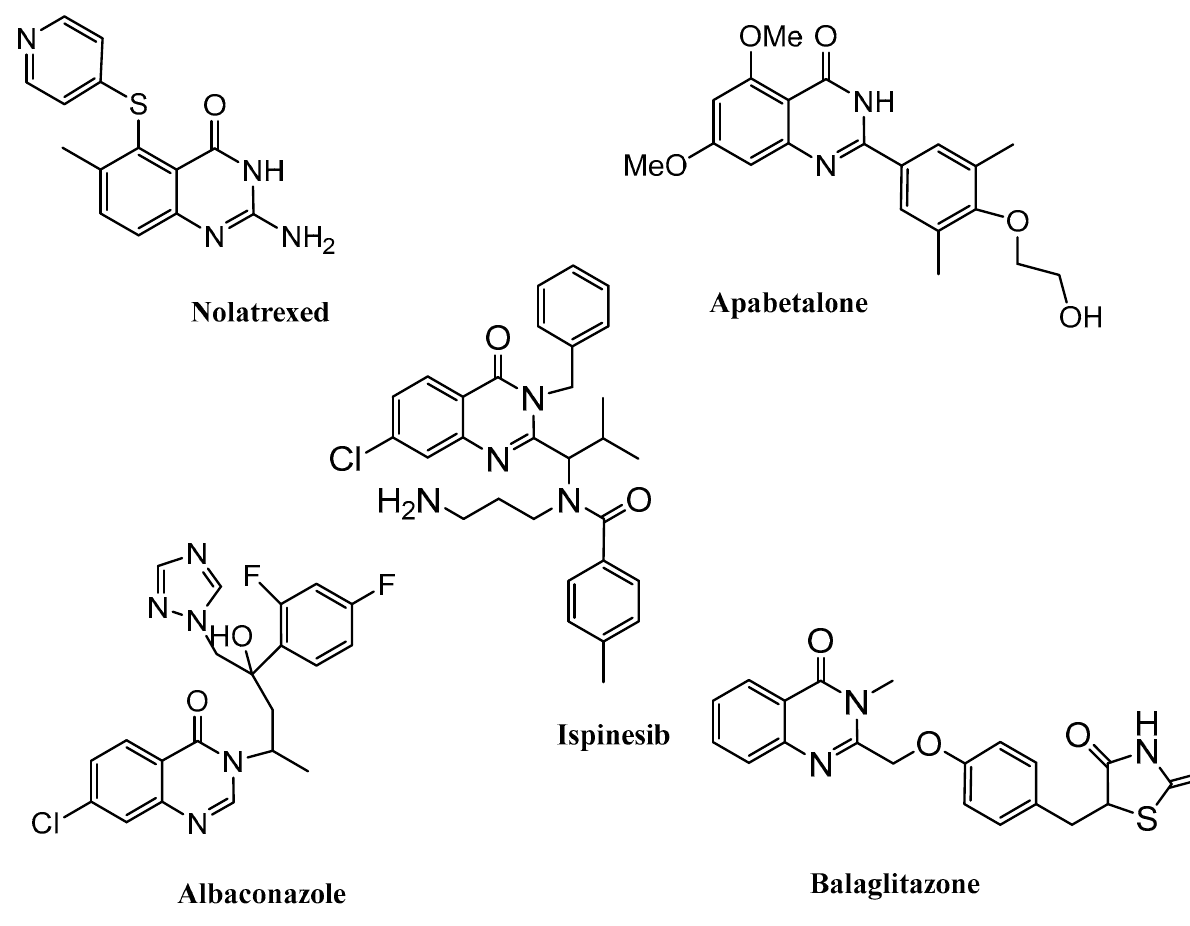
Figure 7 . Investigational 4(3 H )-quinazolinones. Figure 7. Investigational 4(3 H